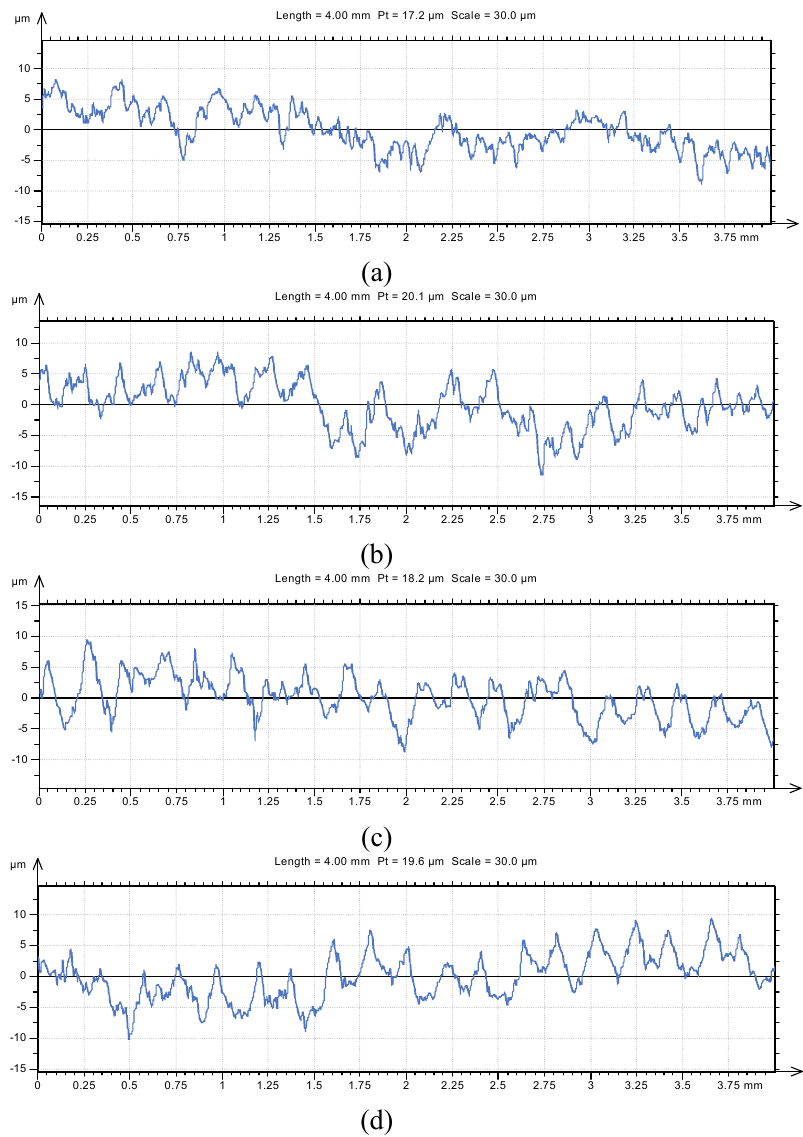
Fig. 7. Surface roughness profiles after turning in dry environment at (a) Run 1; (b) Run 7; (c) Run